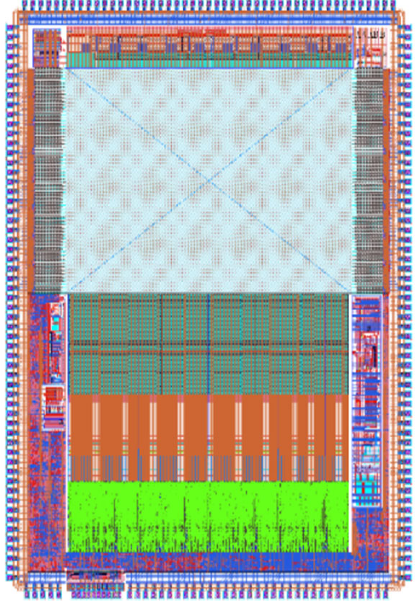
Figure 9. CIS chip overall simulation platform.